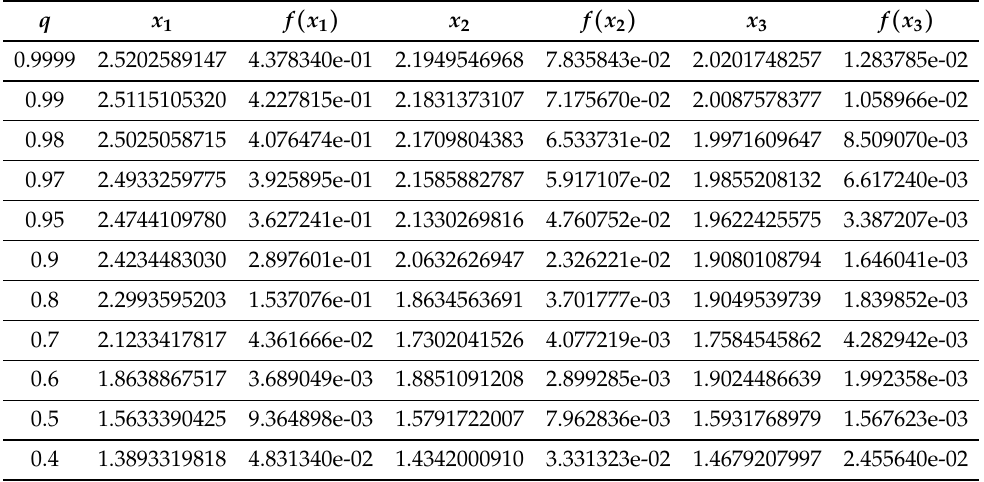
Table 5. The calculated values of x i and f ( x i ) for i = 1,2,3 and different values of q by using QAG